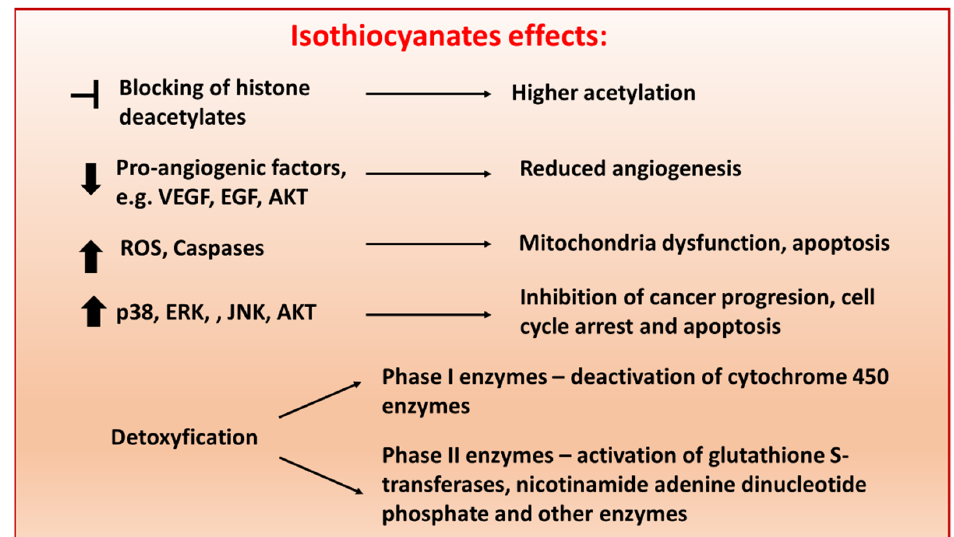
Figure 1. Schematic representation of molecular pathways targeted by isothiocyanates (ITCs) in cancer cells. ITCs exert their anti-tumor activities through various mechanisms, including (i) regulation of the epigenetic machinery, (ii) prevention of metastasis and angiogenesis, (iii) apoptosis via reactive oxygen species-initiated mitochondrial dysfunction (iv) inhibition of cell growth by causing cell cycle arrest and inducing cell death and (v) modulation of phase I and II enzymes [4]. The concentration in which ITCs present biological activity depends on chemical modifications and cell types.